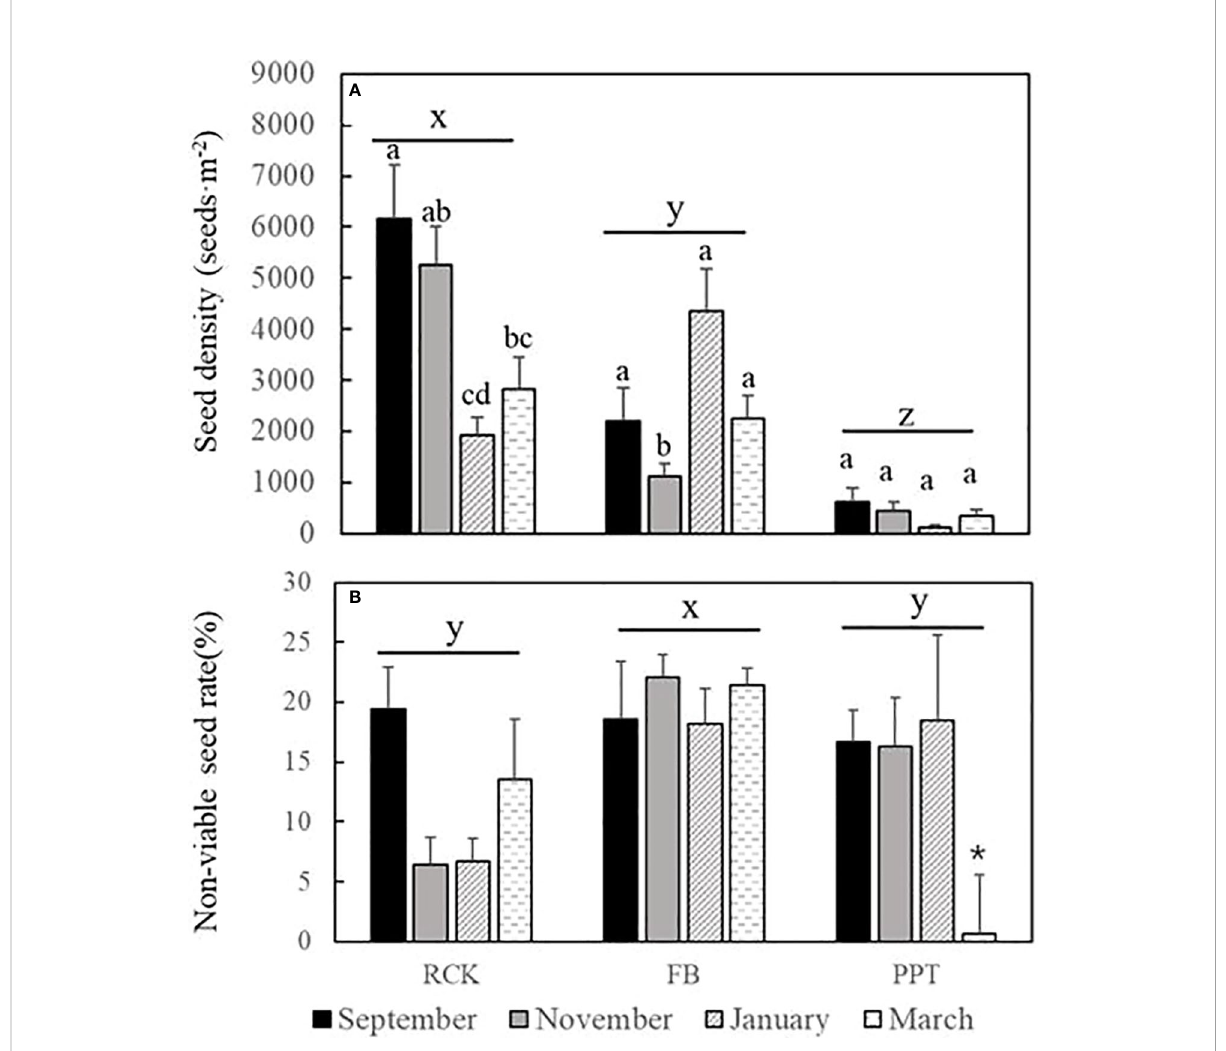
FIGURE 6 The seed density (n=720) and non-viable seed rate (n=48)in RCK, FB, and PPT during 2019-2020 (mean ± SE). (A) the seed density (seeds·m -2 ). (B) the non-viable seed rate (%). Different letters x, y, and z represent signi fi cant difference among the sites. Different letters a, b, and c indicate signi fi cantly different among the survey time in one site. And * indicates the signi fi cant difference between March and the other three investigations at